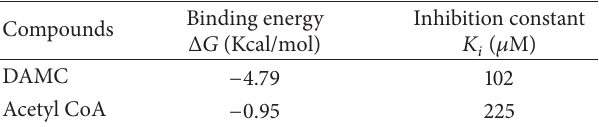
Table 1: AutoDock free energy binding ( Δ𝐺 ) and estimated inhibi- tion constants ( 𝐾 𝑖 ) of the CR substrates (temperature 298.15